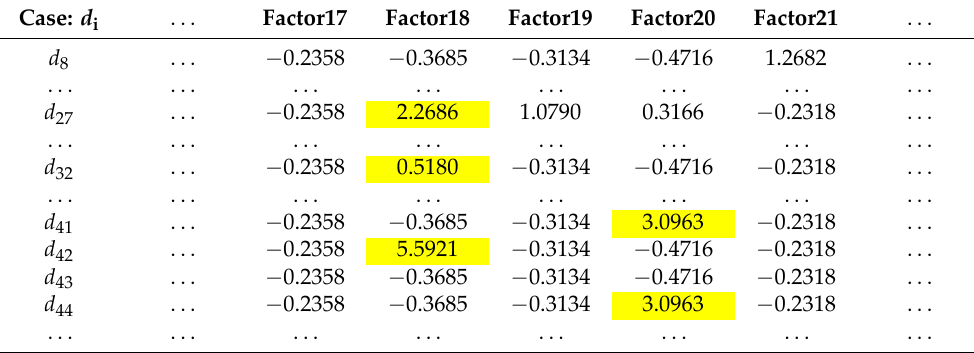
Table 4. Show d i Factor z pairs having the highest FactorScore z (Yellow Cell) on each d i . Case: d